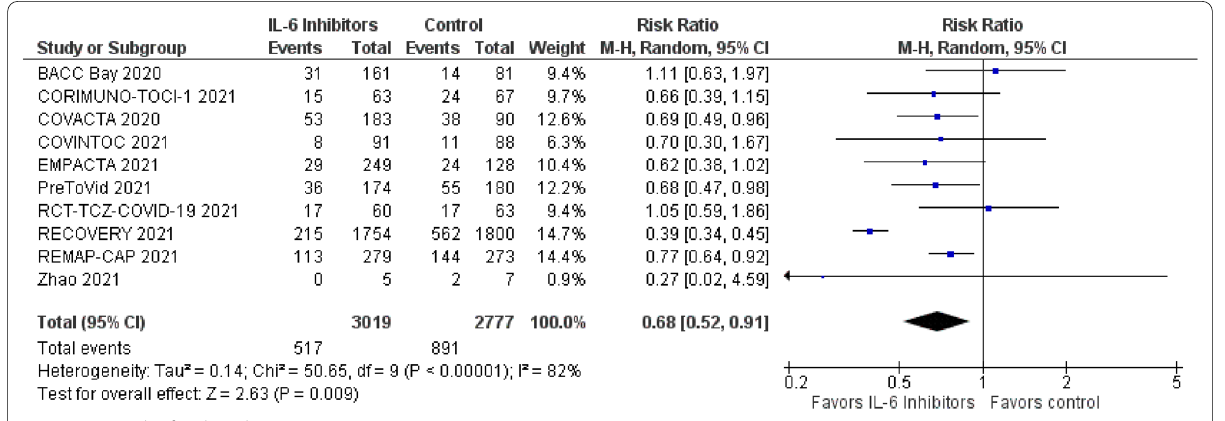
Fig. 4 Forest plot for clinical